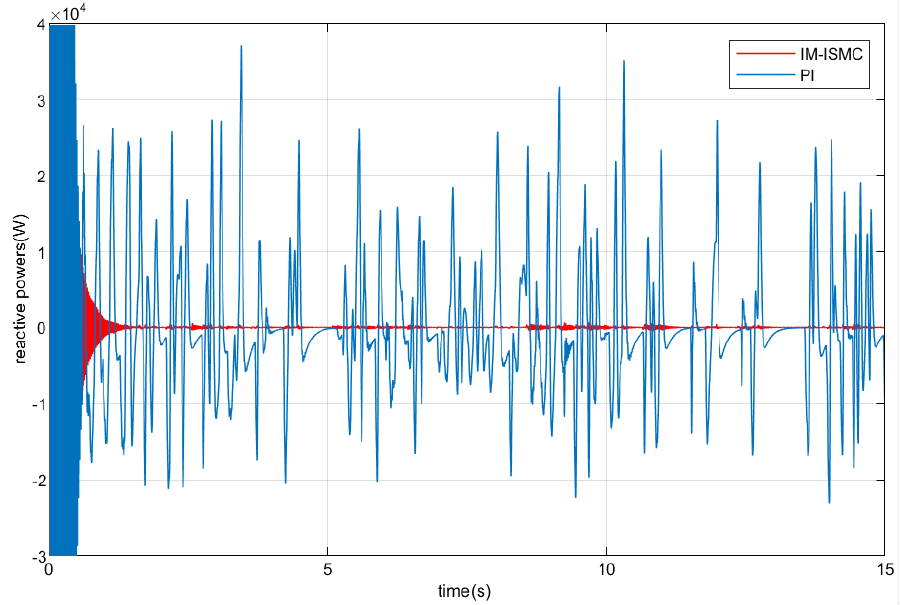
Figure 17. Simulation results of reactive power.